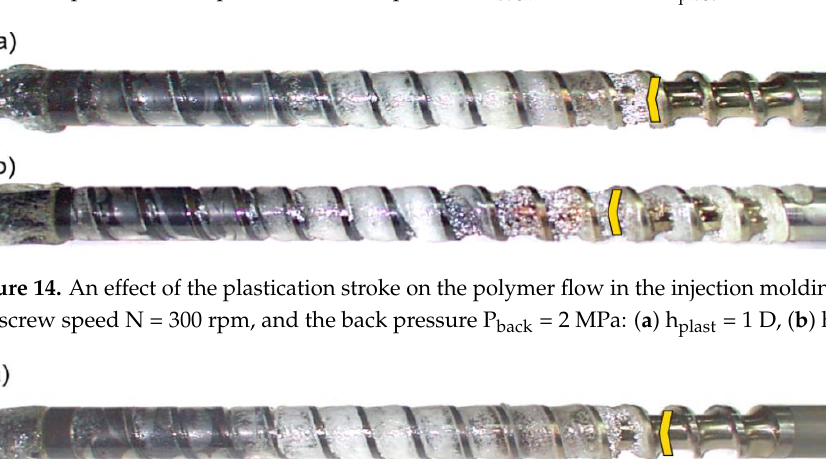
Polymers 2022 , 14 , x FOR PEER REVIEW 12 of 20